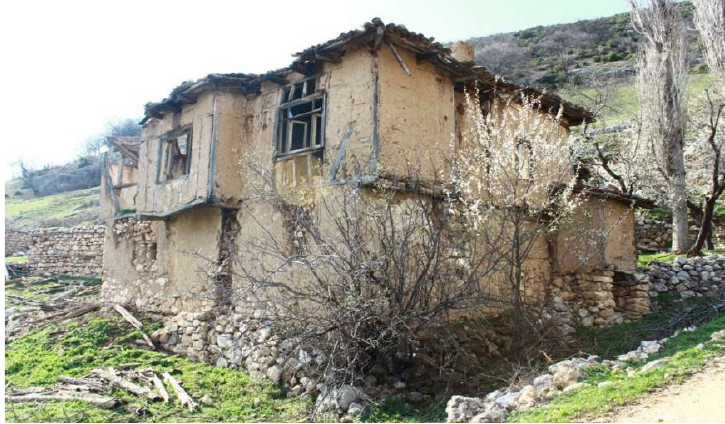
Figure 16 An abandoned village house (photo:authors)